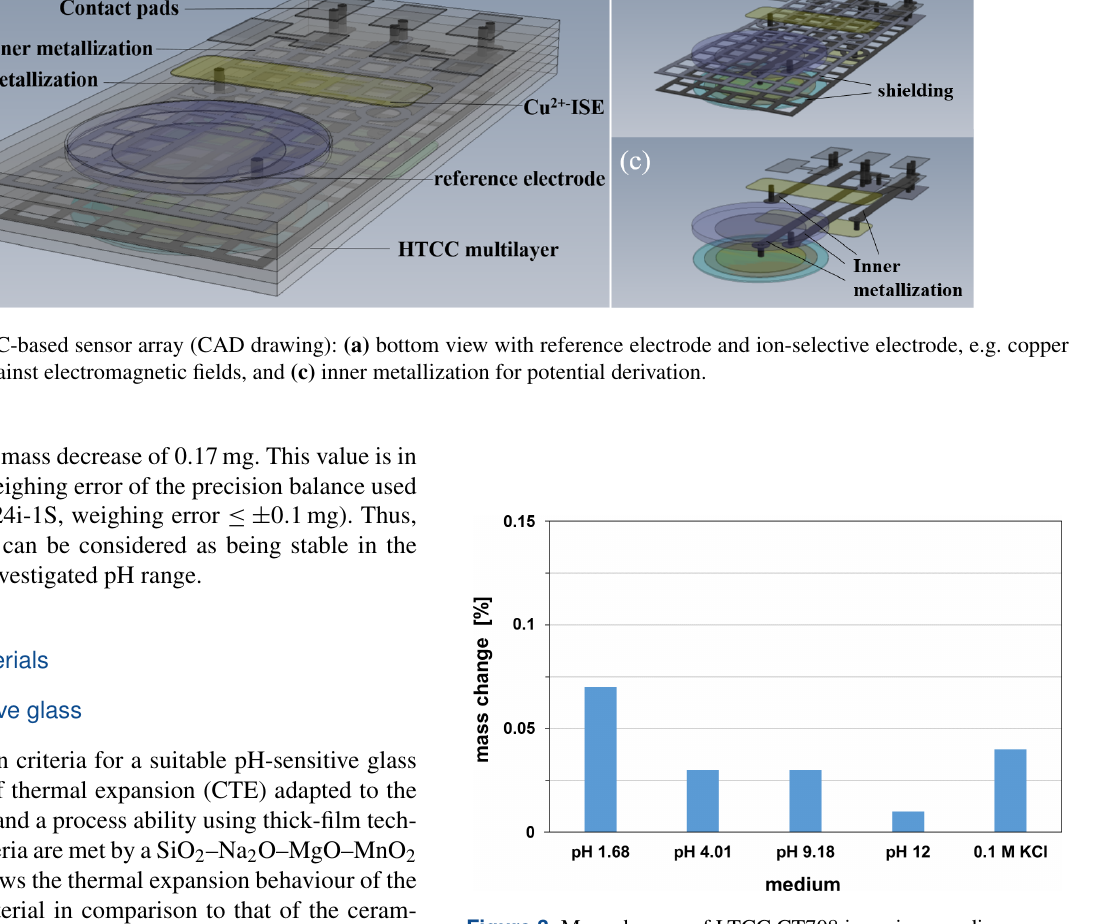
Figure 3. Mass changes of LTCC CT708 in various